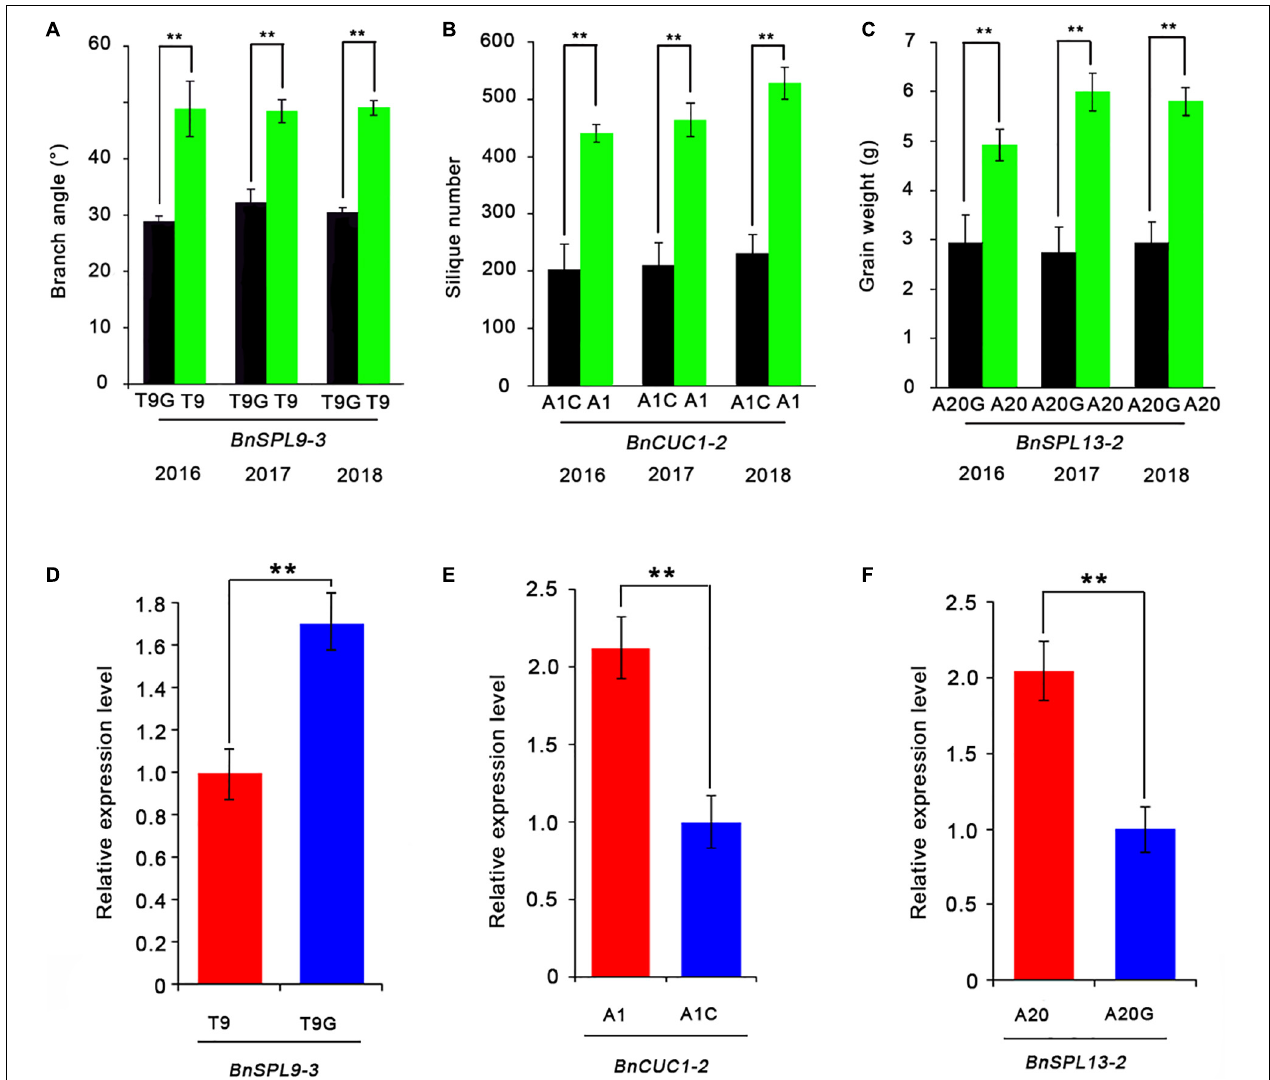
FIGURE 5 | Effects of SNPs in the miRNA target site on target gene expression levels. (A–C) Effects of miRNA target site SNPs on the branch angle (A) , silique number (B) , and seed weight (C) determined by comparing groups with extremely high values (four accessions) and low values (four accessions) for these traits. (D–F) Comparison of the BnSPL9-3 (D) , BnCUC1-2 (E) , and BnSPL13-2 (F) expression levels between the two groups with extremely different phenotypes. ACTIN7 was used as an internal control for analyzing gene expression. Data are presented as the mean ± standard deviation ( n = 3). Significant differences were determined by Student’s t -test: * P < 0.05, **P <